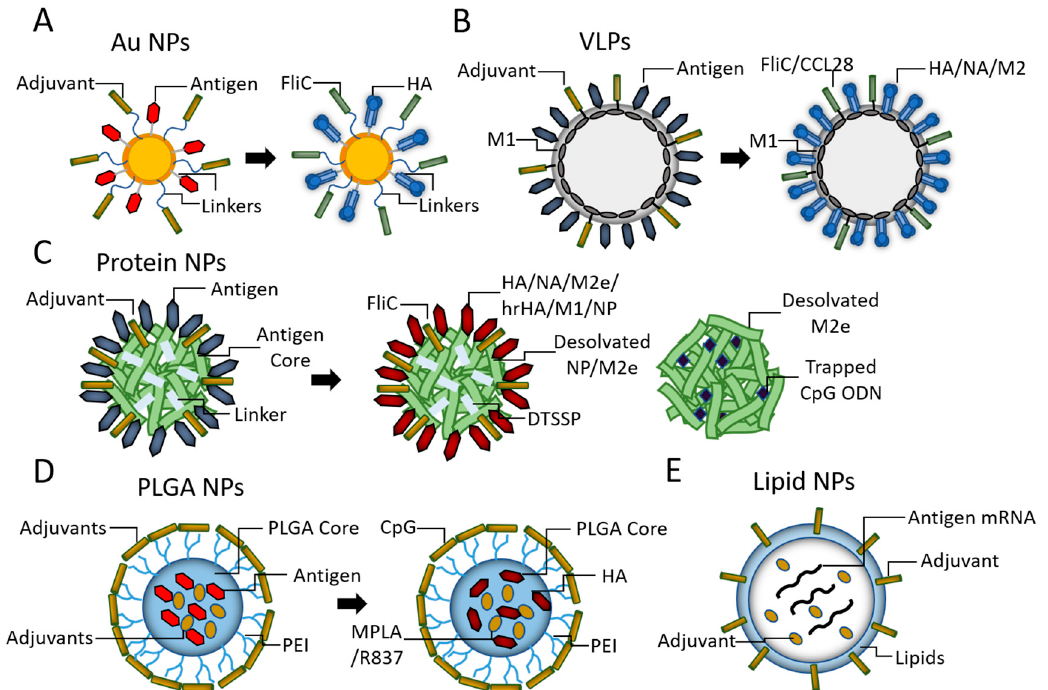
Figure 1. A diagram of different self-adjuvanted nanoparticle (NP) platforms. ( A ) Au NPs. ( B ) virus-like particles (VLP)s. ( C ) Protein NPs. ( D ) biodegradable synthetic polymeric (PLGA) NPs. ( E ) Lipid NPs.